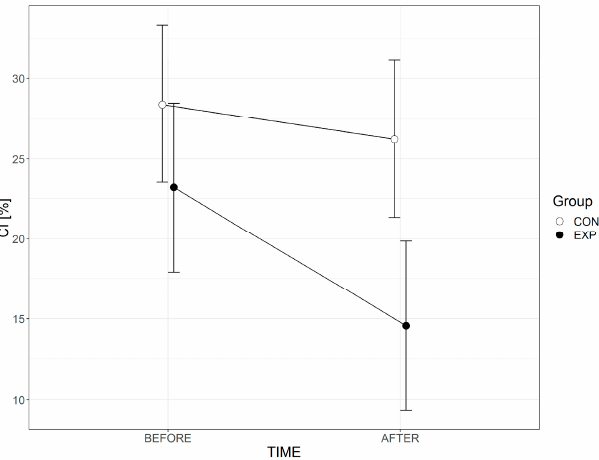
Figure 2. Graphical representation of interaction TIMExGROUP, whiskers indicate 95% confidence intervals as the combination of right and left legs.